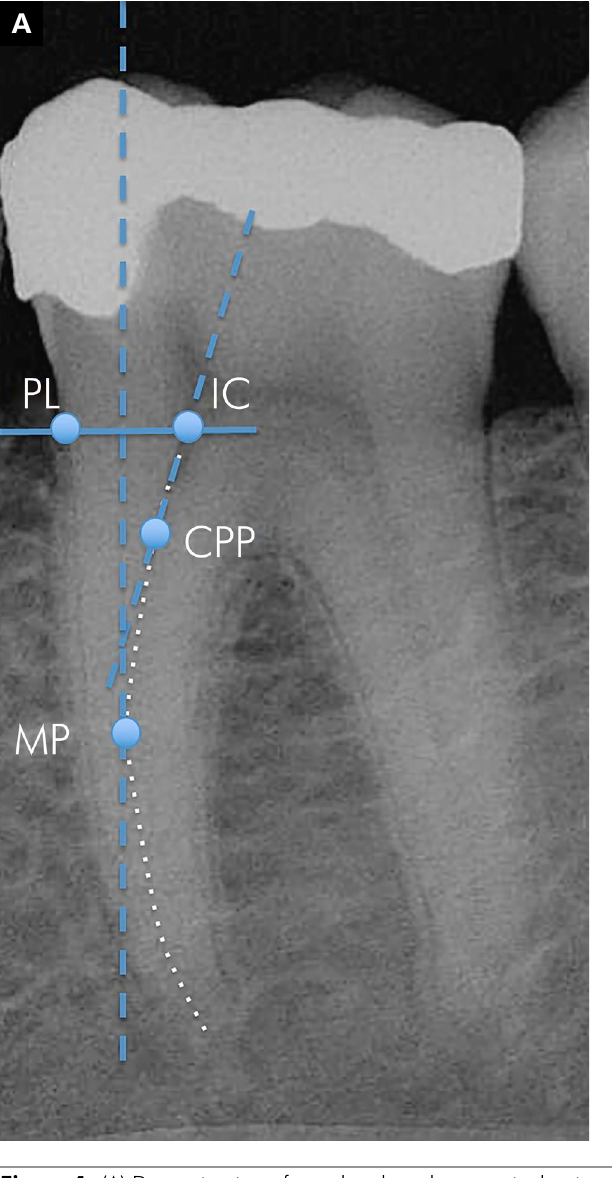
Figure 1. (A) Determination of canal path and anatomical points (IC, CPP, PL, and MP); (B) Grid overlapping the mesial root (*red line indicating zero